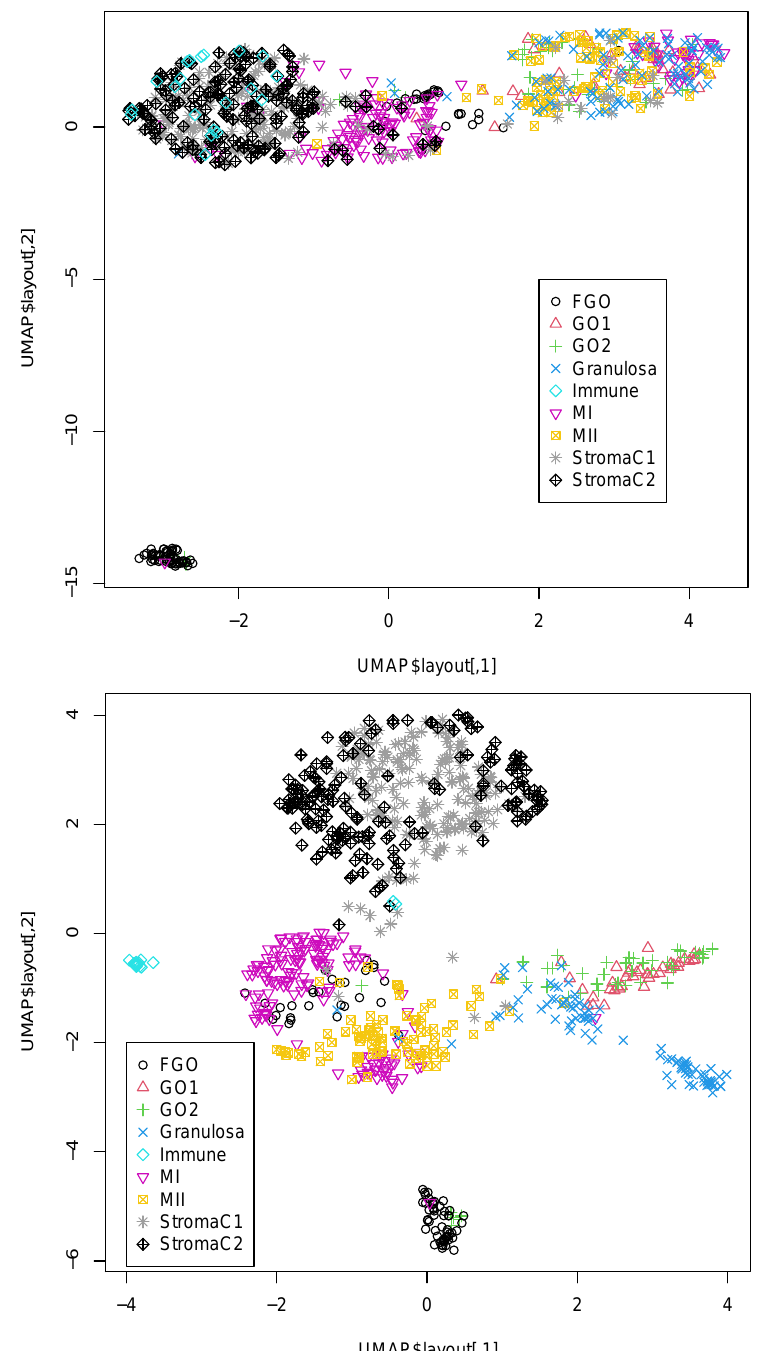
Figure 1. Two-dimensional embedding of singular-value vectors, u (cid:96) , computed by HOSVD applied 2 j to x (cid:96) jk in Dataset 1 (Table 3). Upper: u (cid:96) ,1 ≤ (cid:96) 2 ≤ 20 when only DNA methylation and accessibility 2 j ( k = 2,3 ) are integrated. Lower: u (cid:96) ,1 ≤ (cid:96) 2 ≤ 30 when all three omics data points (1 ≤ k ≤ 3) are 2 j integrated. Default settings other than custom.config$n_neighbors = 100 were